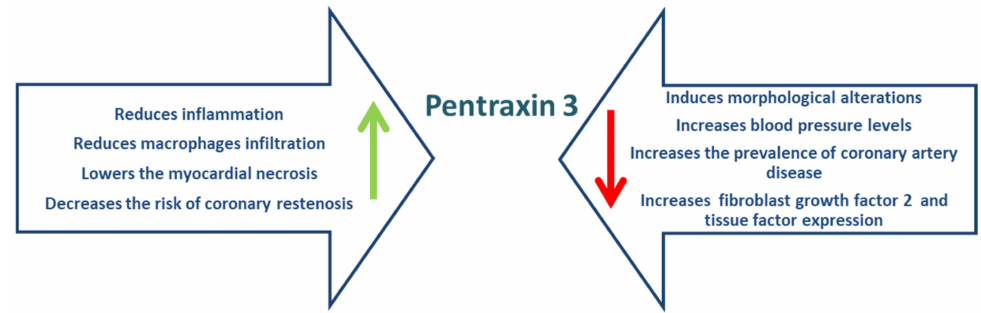
Figure 6. Effects of pentraxin 3 (adapted after